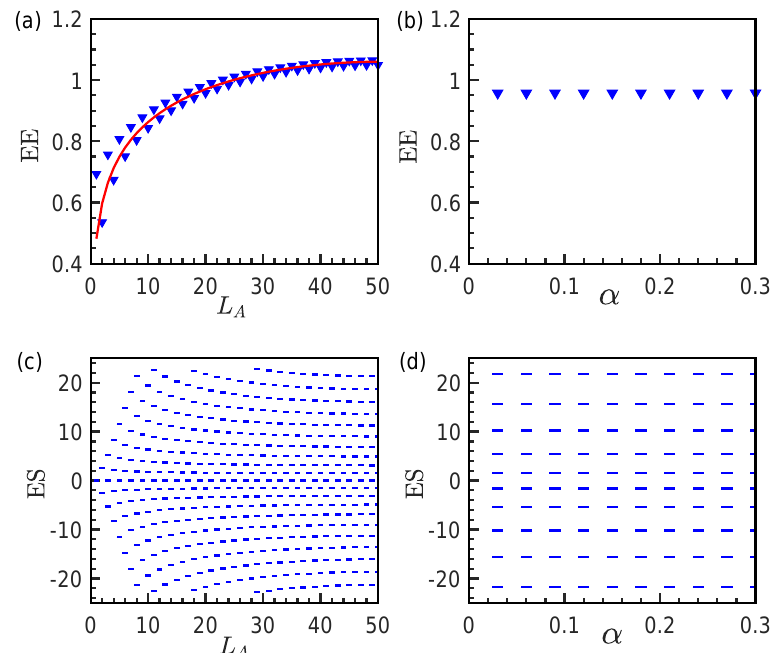
Figure 3: Entanglement entropy S (a) v.s. L with L = 100, α = 0.1 and (b) v.s. α A o EE = 20; Entanglement spectrum (c) v.s. L with L = 100, L with L = 100, α = 0.1 A o A o = 20 for non-reciprocal model in Eq. (26). In (a), and (d) v.s. α with L = 100, L A o S calculated via the definition in Eq. (10) marked by blue triangles is consistent EE with the formula of S guided by a red line that is inferred by the duality. (b) shows EE S is independent of α . (c) depicts EE dependence on the size of region . (d) EE A o shows EE is not altered when α changes. All calculations are conducted under open boundary condition at half-filling with t =